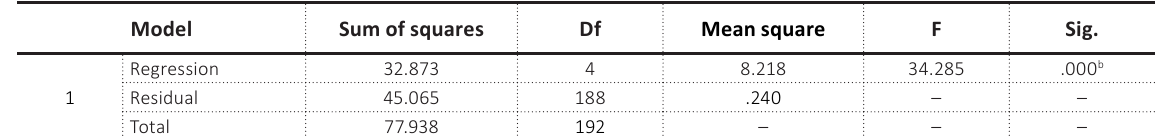
Table 3. ANOVA a